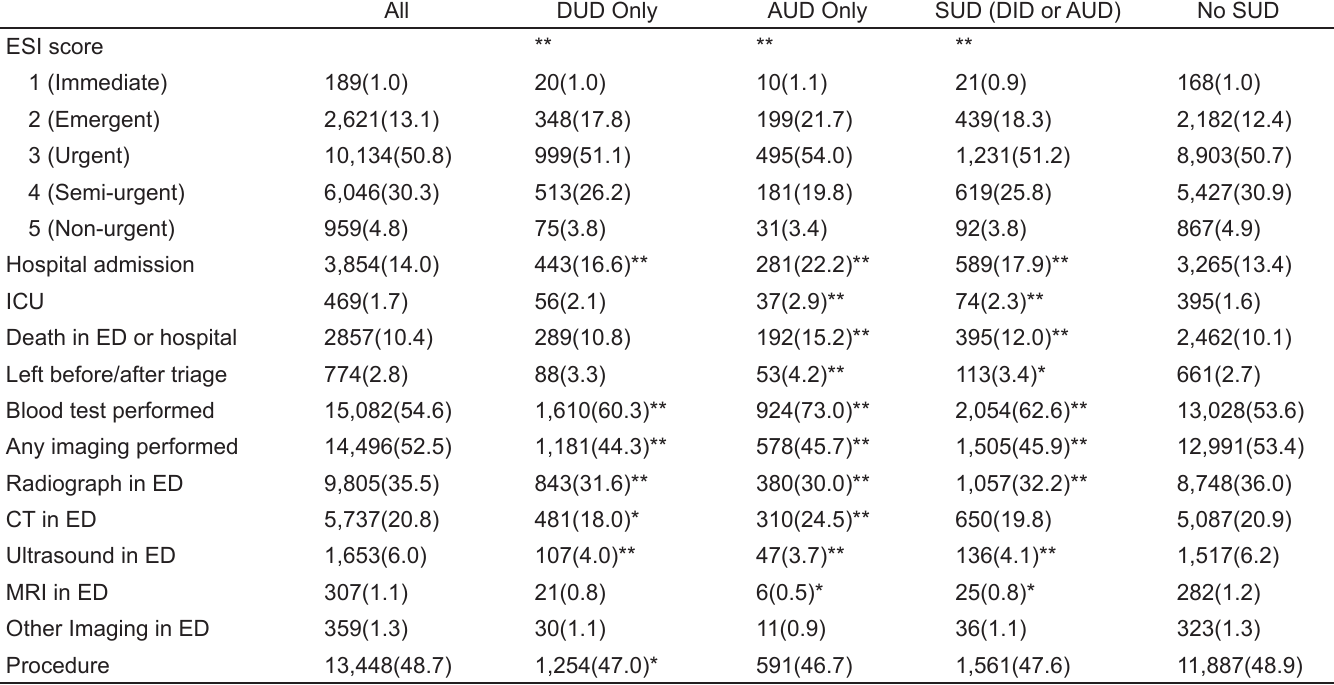
Table 4. Proportion of Emergency Severity Index, hospital admission, ICU admission, medical resources utilization, stratified by alcohol/ drugs substance use disorder, *NHAMCS